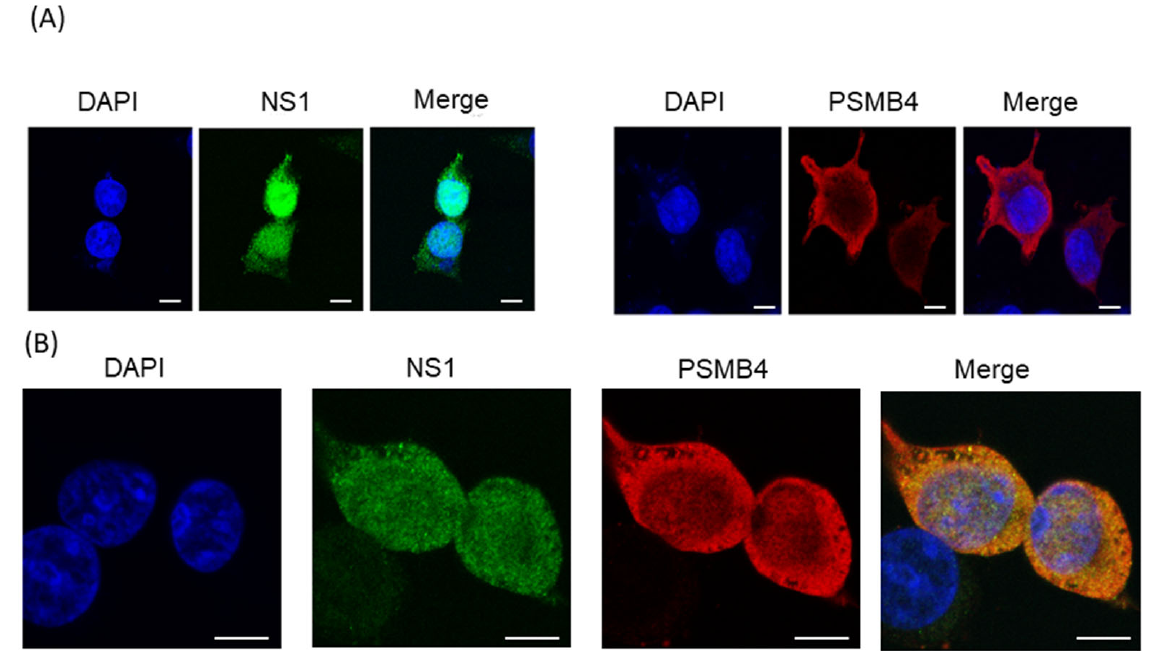
Figure 3. Confocal microscopy analysis of exogenous PSMB4 and IAV NS1 proteins in cultured cells. A549 cells were ( A ) transfected individually with the plasmid that expressed the NS1 protein with a V5 tag (left panel), the plasmid that expressed the PSMB4 protein with the myc tag (right panel) or ( B ) co-transfected with these two plasmids. Forty-eight hours after transfection, the cells were fixed and stained with mouse anti-myc, followed by RITC-conjugated anti-mouse antibody, and finally with FITC-conjugated anti-V5 antibodies. Blue, nucleus stained with DAPI; red, PSMB4 protein; green, NS1 protein; yellow, co-localization of NS1 and PSMB4 proteins. The scale bar represents 10 mm.